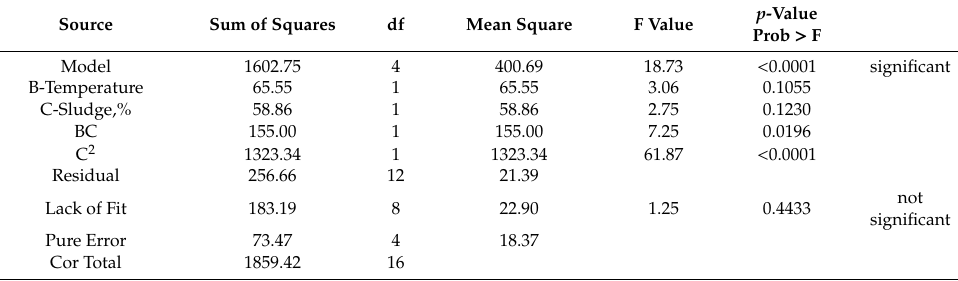
Lack of Fit Pure Error